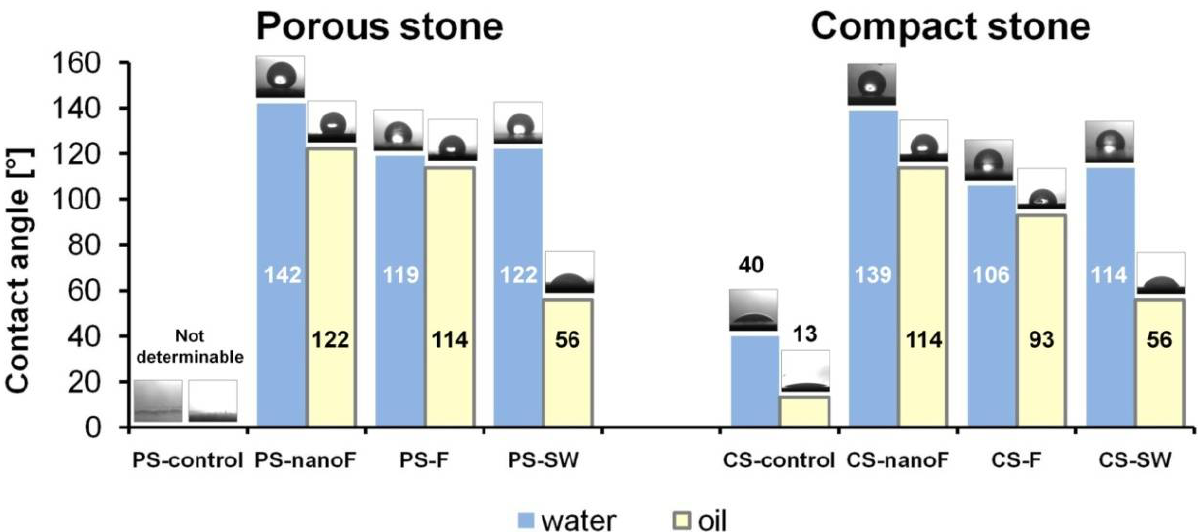
Figure 3. Contact angle values; the water and oil droplets on the stone surfaces are also shown.